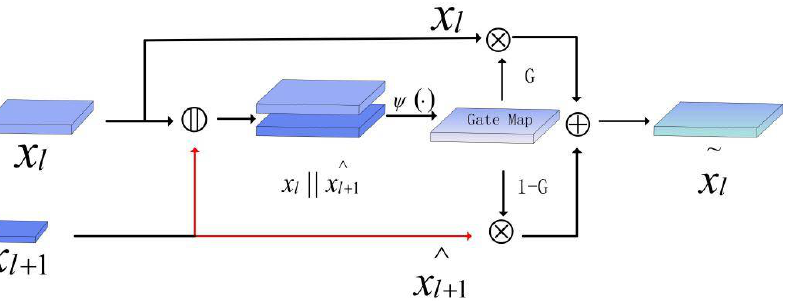
Figure 4. Computation details of our proposed gated high–low-level feature fusion. The red arrow denotes the operations of bilinear interpolation followed by a 1 × 1 convolution.